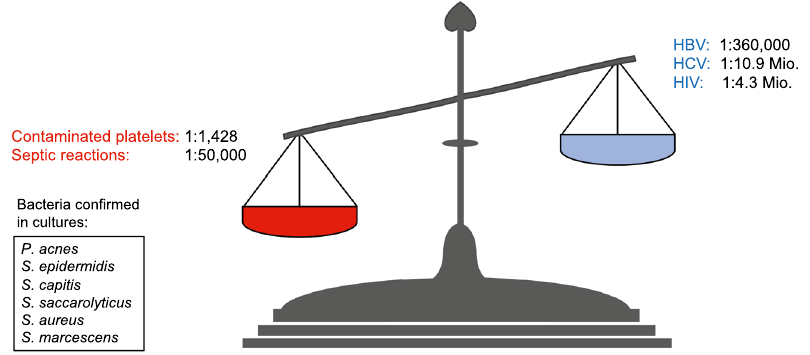
Figure 1: Risk of bacterial and viral transmission [37,